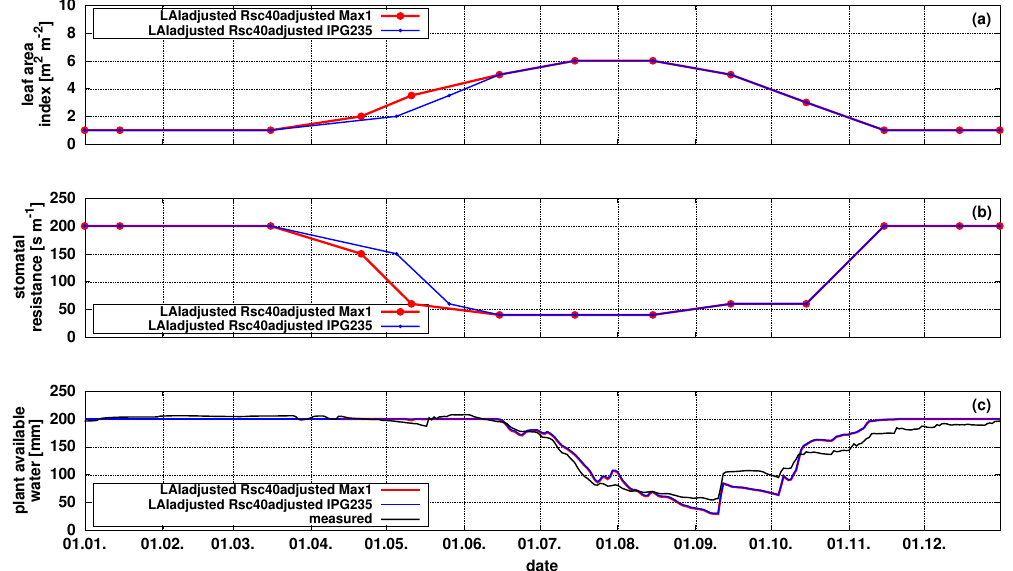
Figure 6. Leaf area index and stomatal resistance as parameterised from adjusted values for 2013. Maximum of leaf area index is set to 6, minimum of stomatal resistance is set to 40sm − 1 . Leaf unfolding (LU) is determined by the dynamic phenology approach implemented in WaSim, using the Max1 and IPG235parameterisation. The annual course of leaf area index and stomatal resistance is orientated on measurements for leaf area and used as calibration parameter for stomatal resistance. Simulations results using the two combinations of leaf area index and stomatal resistance are shown as plant available soil water, calculated till 1m soil depth and compared to values based on soil water content